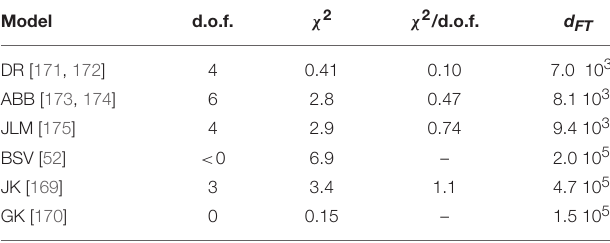
TABLE 6 | Comparison of different SO (10) models fitted to the data.